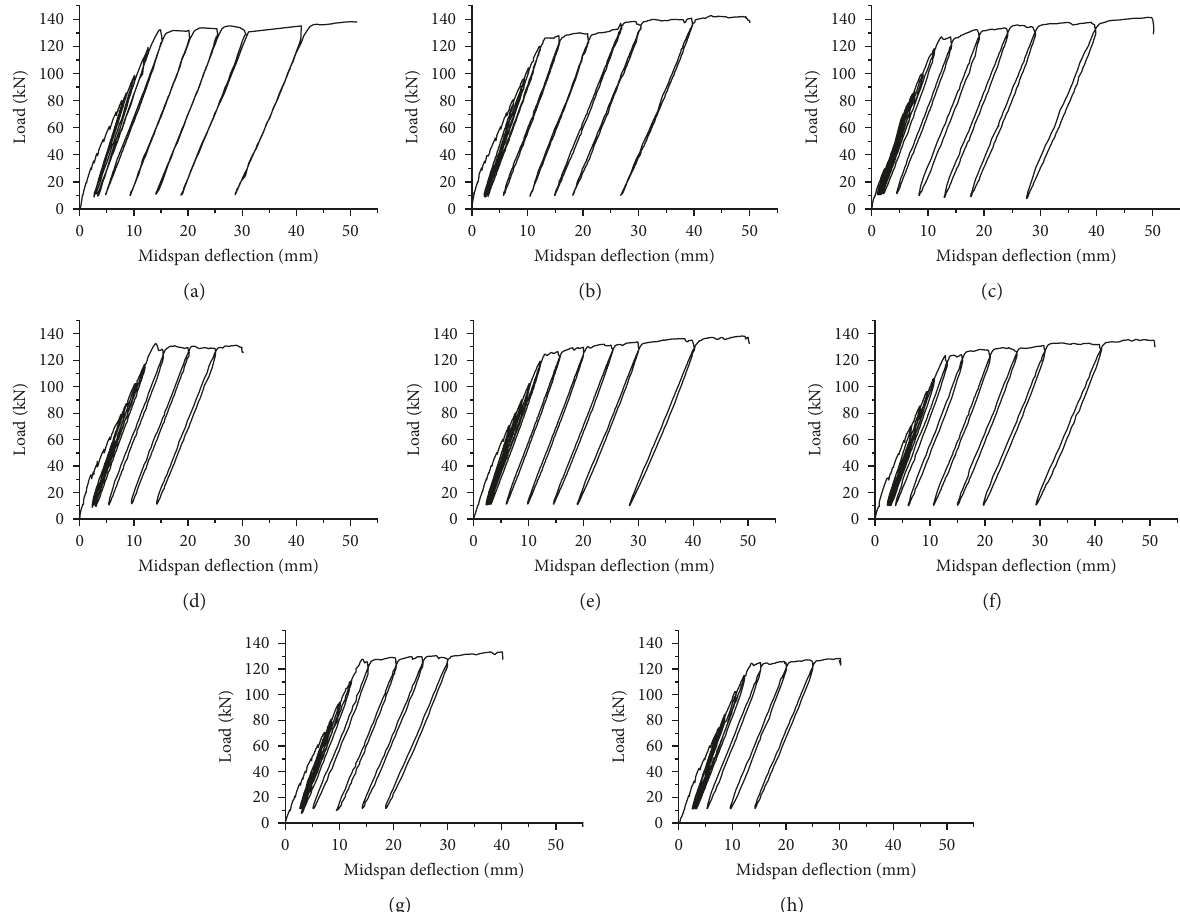
Figure 10: Load-deflection curves of the eight specimens. (a) RCB-0, (b) RCB-33, (c) RCB-66, (d) RCB-100, (e) HRCB-0, (f) HRCB-33, (g) HRCB-66, and (h)